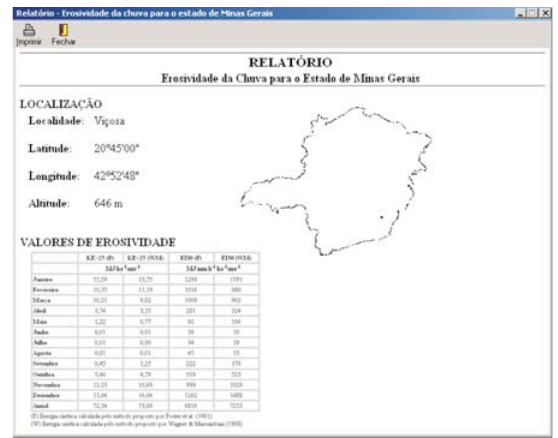
Figura 2. Tela de apresentação do NetErosividade MG .